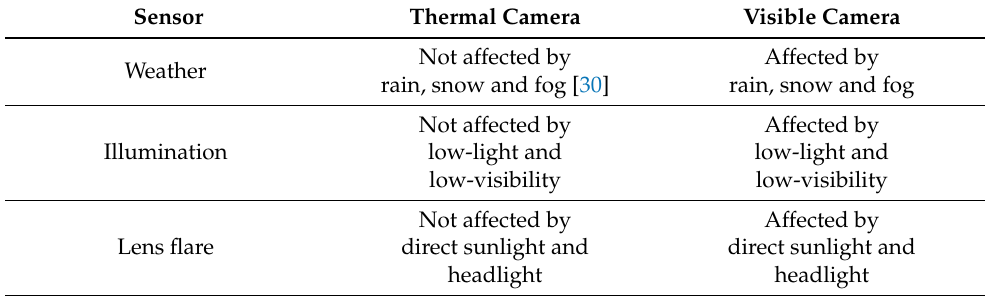
Table 2. Comparative study of the properties of the thermal and visible